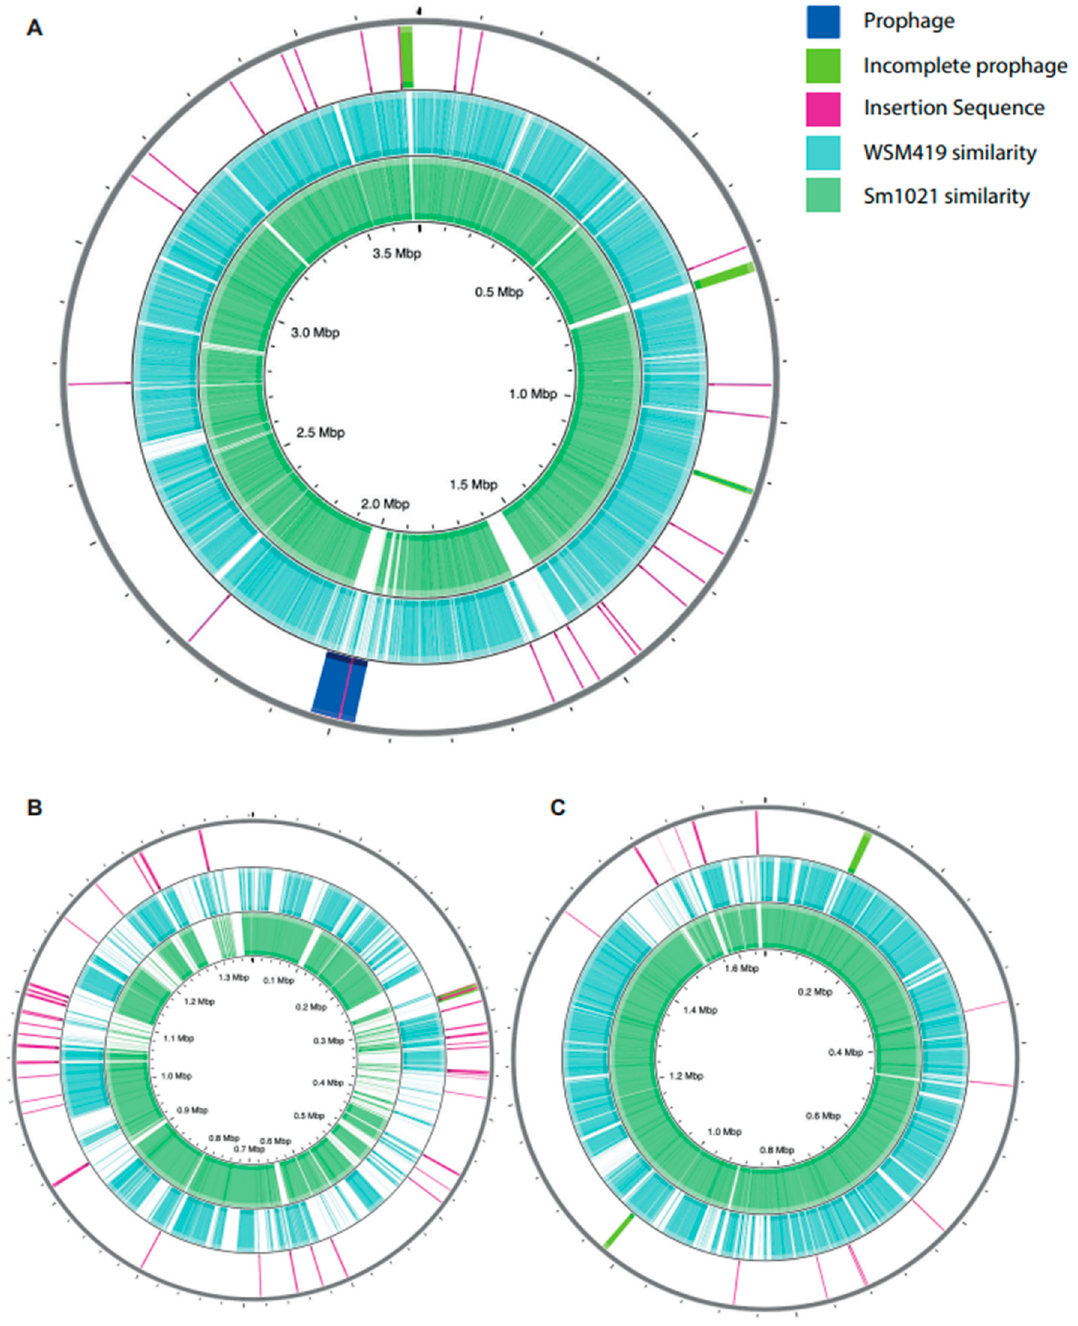
Figure 2. Comparative genomics of Sm1021, WSM1022 and WSM419. ( A – C ) Circular plots representing sequences of WSM1022 chromosome ( A ), pA ( B ) and pB ( C ). Innermost rings (green) show sequence similarity to corresponding replicon of Sm1021. Middle rings (light blue) show sequence similarity to corresponding replicons of WSM419. Outer rings show locations of IS and prophage sequences.